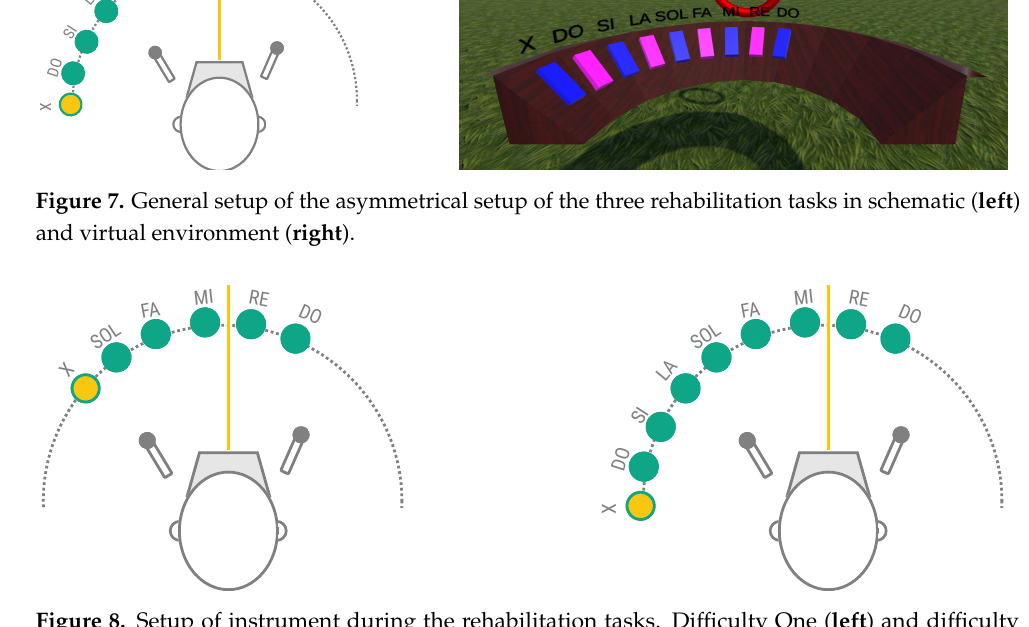
Figure 8. Setup of instrument during the rehabilitation tasks. Difficulty One ( left ) and difficulty Four ( right